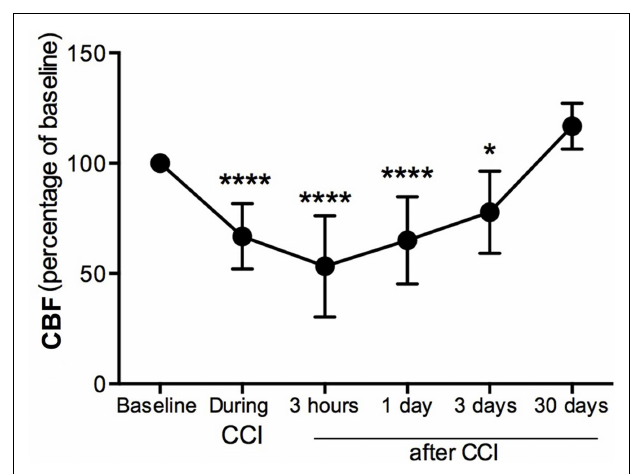
FIGURE 1 | Cerebral blood flow decreases in the pericontusional region after CCI injury . Cerebral blood flow (CBF) measurements were expressed as percentage of baseline levels before injury. CBF was reduced in the injured cerebral cortex during CCI injury, and at 3h, 1dpi, and 3dpi; it increased at 4weeks after CCI injury.Values are expressed as the mean ± SD, n = 8–10 per group, * p < 0.05, *** p < 0.0001 compared to